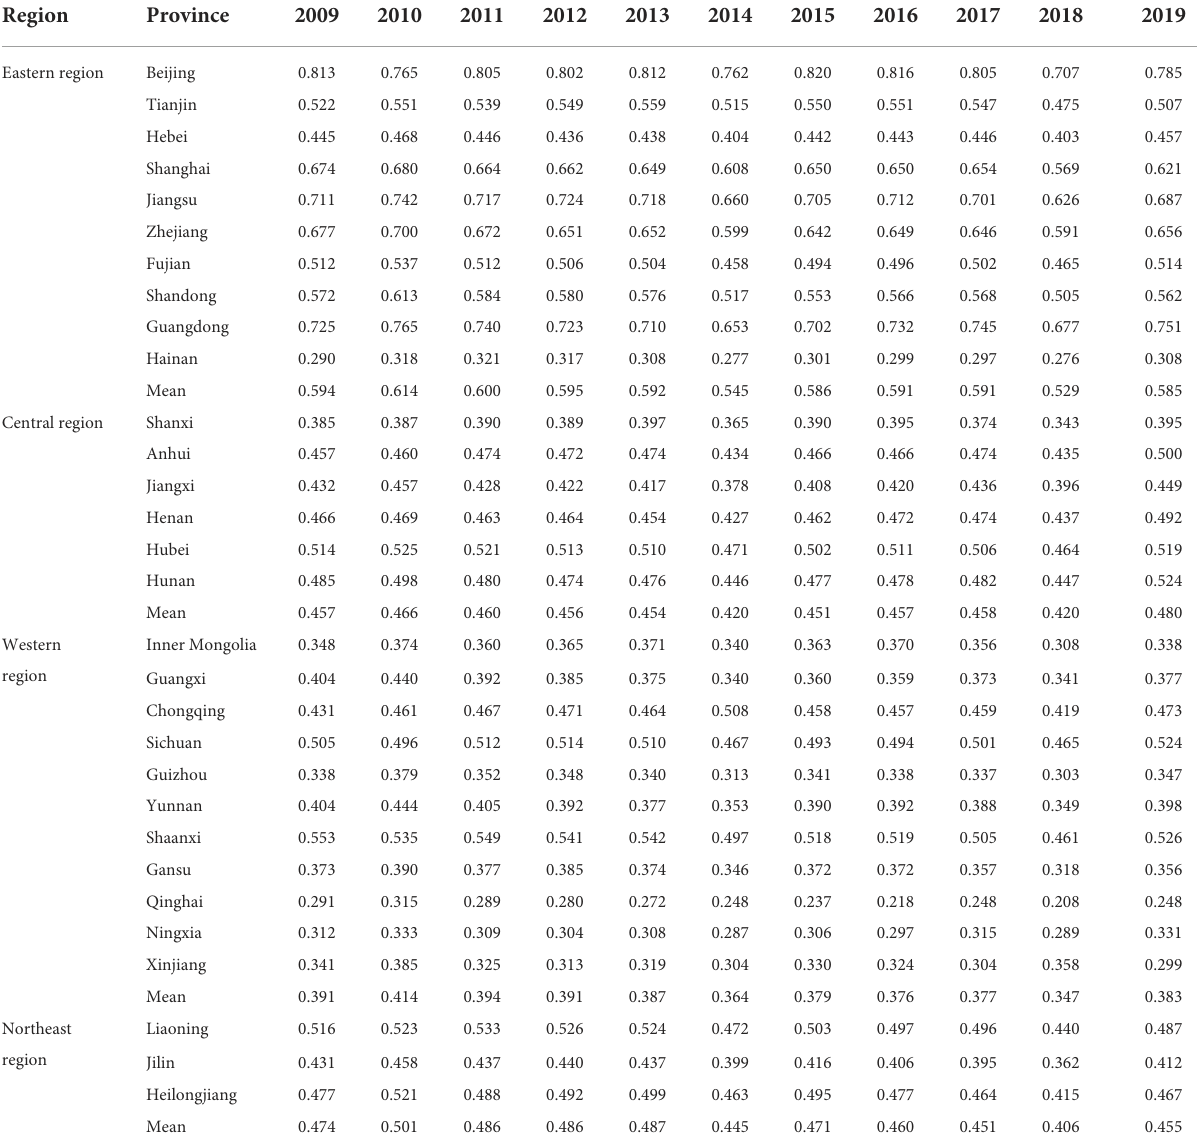
TABLE 4 Coupling coordination degree of the “LCD-TI-NU” system, 2009–2019.